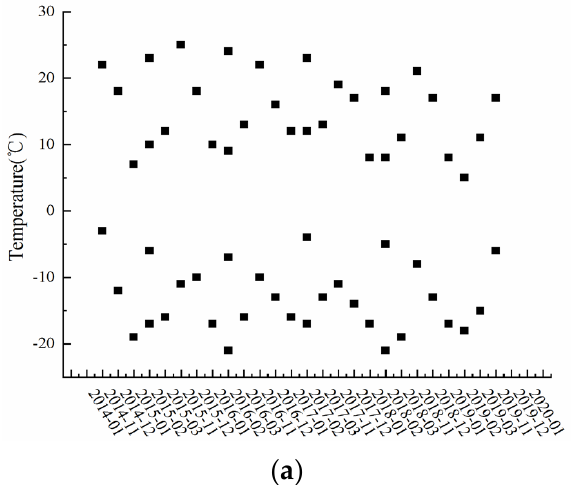
Figure 3. Temperature curve. ( a ) Winter temperature change curve in Xining (in recent years); ( b ) sine curve set during the test.